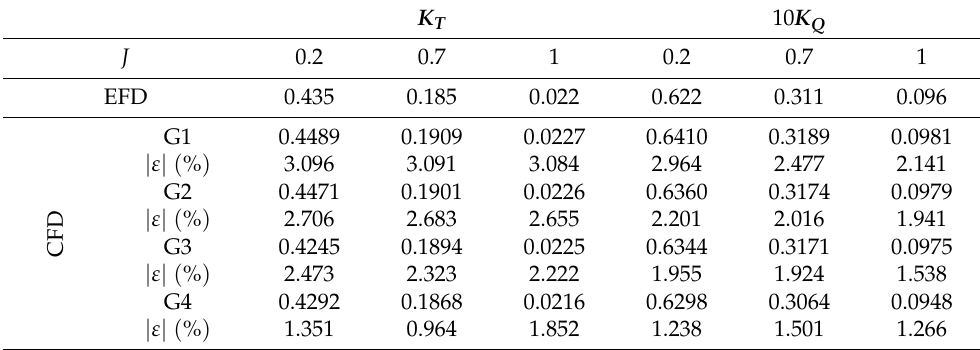
Table 2. Grid sensitivity test. Comparisons between the thrust and torque coefficients measured (EFD) and computed (CFD) on the four meshes (G1–G4). K